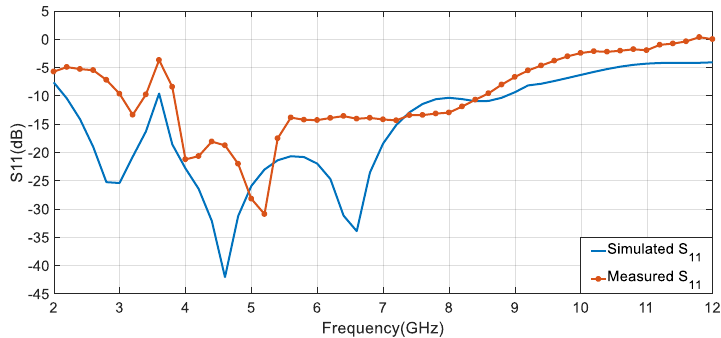
Figure 7. S 11 for the fabricated microstrip antenna.